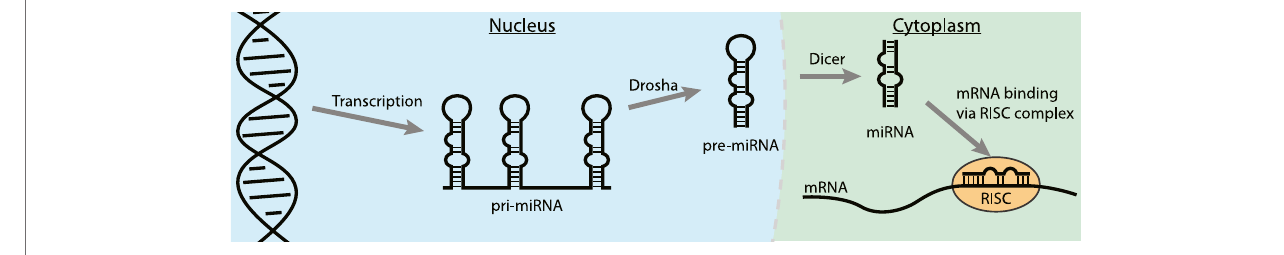
FIGURE 8 | The steps in the biogenesis of miRNA. Binding to a pre-miRNA can block the pathway and inhibit miRNA downstream effects.